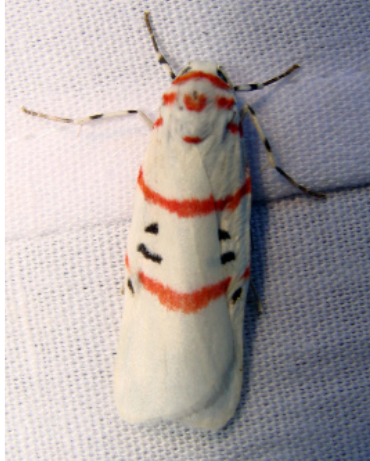
Image 21. Spilosoma dalbergiae (Moore) (Erebidae) Image 22. Cyana signa (Walker)